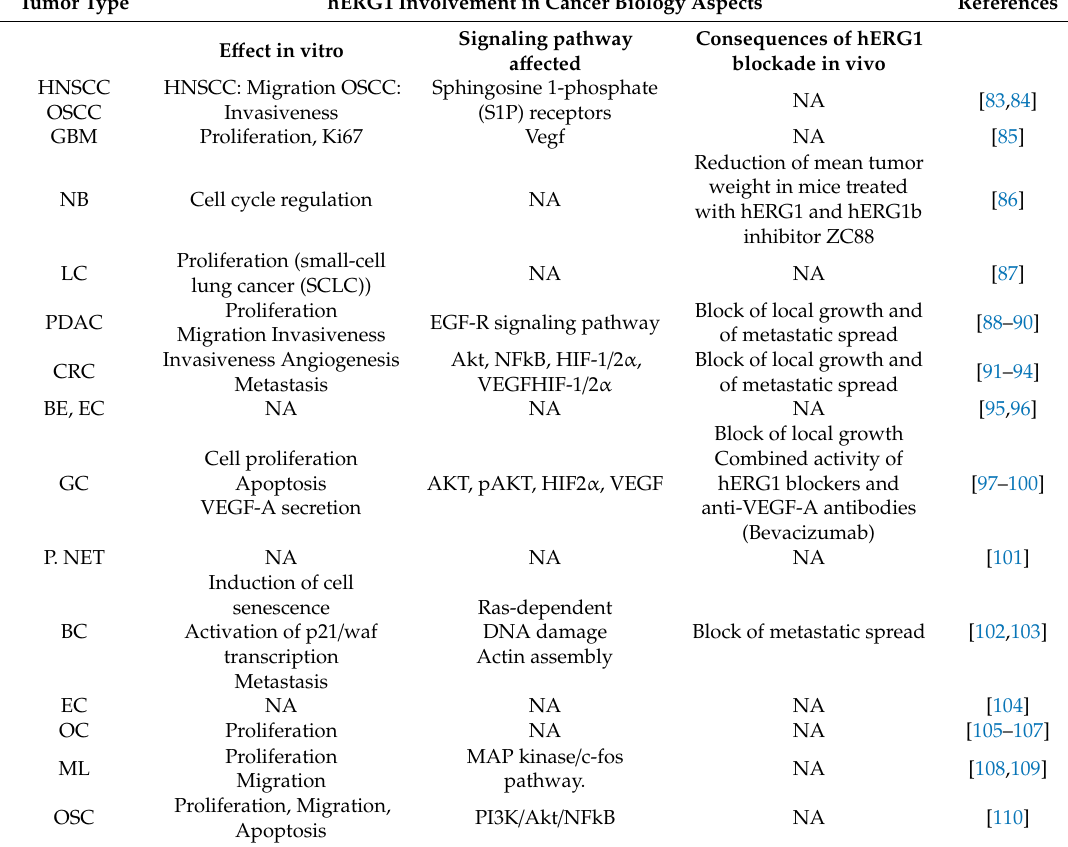
Table 4. Di ff erent human solid tumors in which the Kv11.1 (hERG1) ion channel is expressed, enlightening pre-clinical and clinical aspects in which it is involved. The di ff erent types of cancers have been indicated using acronyms as follows: Head&Neck, HNSCC; Oral squamous cell carcinoma, OSCC; Glioblastoma Multiforme, GBM; NB, neuroblastoma; BC, breast cancer; PDAC, pancreatic cancer; P. NET, pancreatic neuroendocrine tumor; CRC, colorectal cancer; LC, lung cancer; HC, head cancer; PC, prostate cancer; EC, esophageal cancer; GC, gastric cancer; BE, Barrett’s Esophagus; EC, endometrial cancer; OC, ovarian cancer; ML, melanoma; OSR, osteosarcoma.